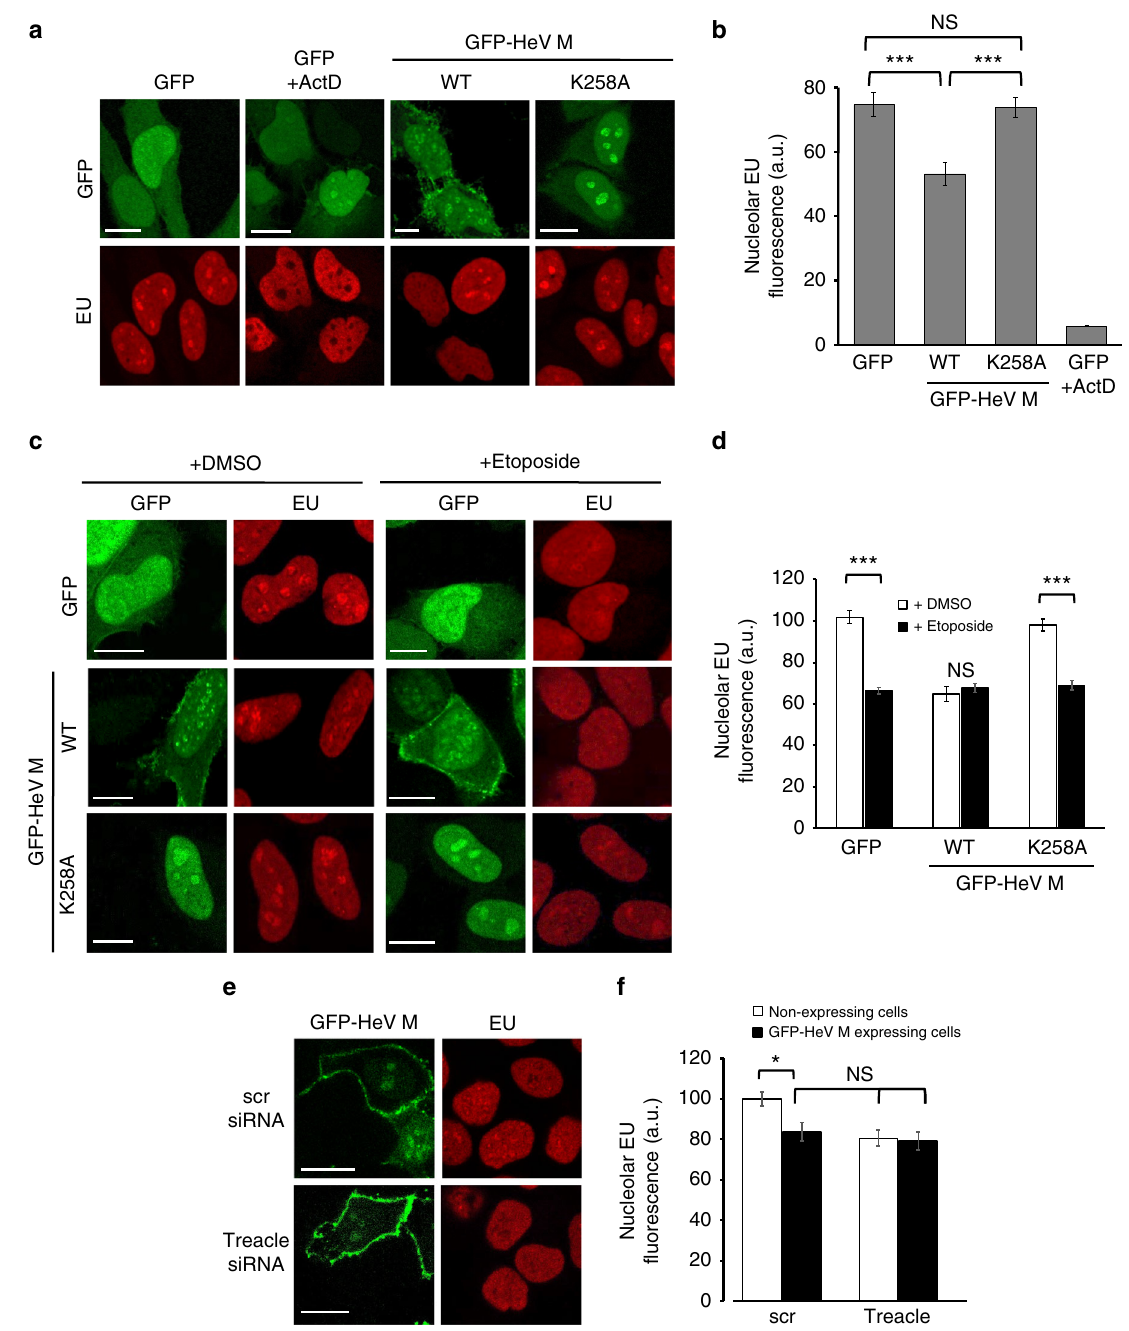
Fig. 7 HeV M protein expression inhibits rRNA production. HeLa cells were transfected to express the indicated GFP-fused proteins before treatment with or without ActD for 1 h ( a , b ), or DMSO or etoposide (3 h) ( c , d ), and labeling of nascent RNA as described in the legend to Fig. 6 ( fi xation at 16 h p.t.; histogram shows mean nucleolar EU fl uorescence ± s.e.m.; n ≥ 31 nucleoli, data from a single assay, representative of six independent assays for b ; n ≥ 39 nucleoli, data from a single assay, representative of three independent assays for d ). e , f HeLa cells were transfected with scrambled (scr) or Treacle siRNA followed by transfection to express GFP-HeV M protein and labeling of nascent RNA ( fi xation 16 h p.t.; histogram shows mean nucleolar EU fl uorescence ± s.e.m., n ≥ 23 nucleoli, data from a single assay representative of three independent assays). Statistical analysis used Student ’ s t -test; * p < 0.05; **, p < 0.01; *** p < 0.001; NS, Non-signi fi cant. Scale bars correspond to 15 μ